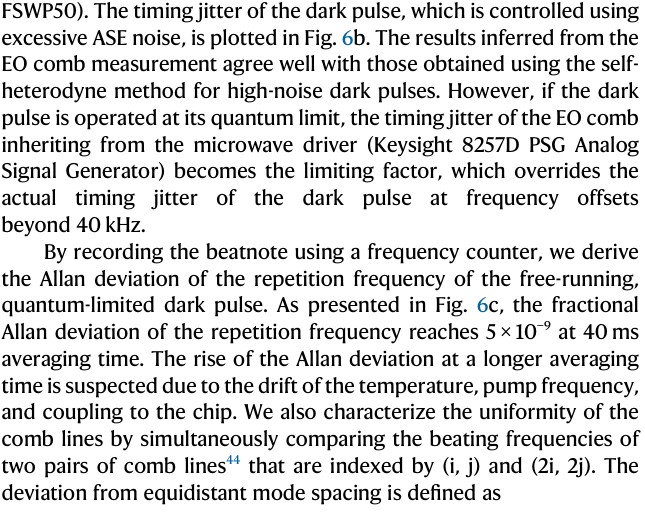
Fig. 6 | Coherence of dark pulses measured by an electro-optic (EO) frequency comb.a Schematicillustrationofexperimentalsetup.TheEOcombisderivedfrom the very same pump laser of the dark pulse using cascaded phase modulators and intensity modulators. Two pairs of comb lines are selected using a programmable fi lter for further characterization. b Timing jitter of the dark pulse with different injected ASE power. Measurements performed using the delayed self-heterodyne method and the EO comb are plotted as solid and dashed lines, respectively.